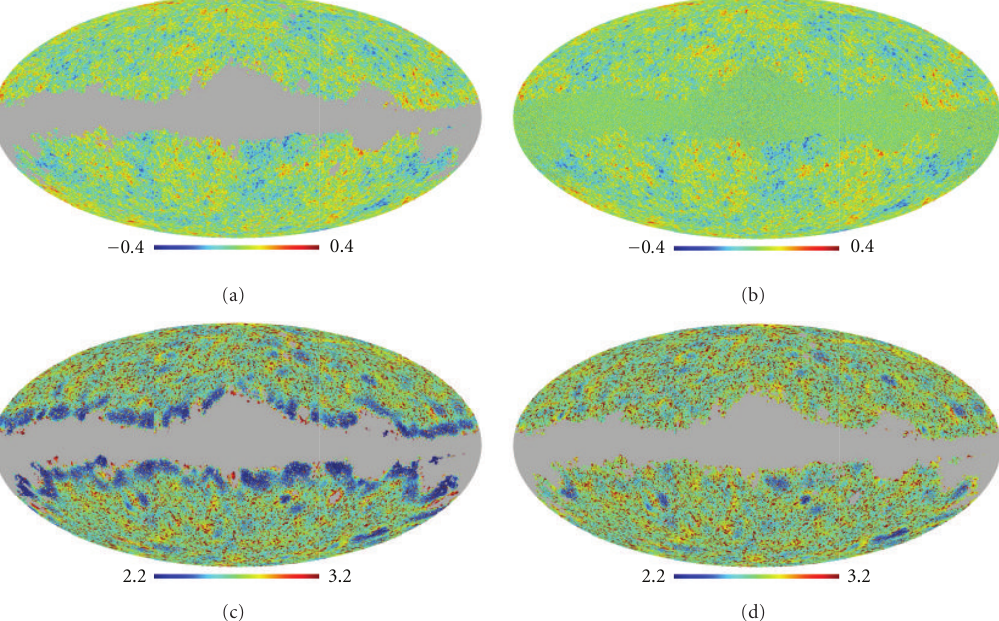
Figure 3: The two plots on the left-hand side illustrate the original 5-year WMAP data of the coadded VW-band (above) and the related colour-coded α -response (below) for a scaling range of r = 0 . 175. The galactic plane and several secondary spots are masked out by the KQ75-mask [46]. The equivalent plots for the mask-filling technique are arranged on the right-hand side.